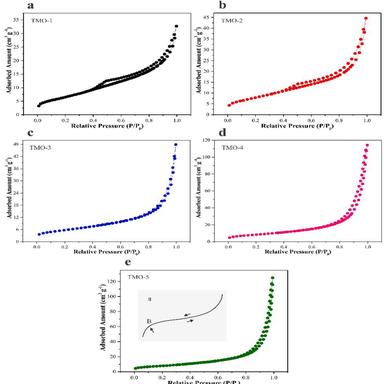
N2 adsorption–desorption isotherms at 77 K for the as-synthesized TMOs.